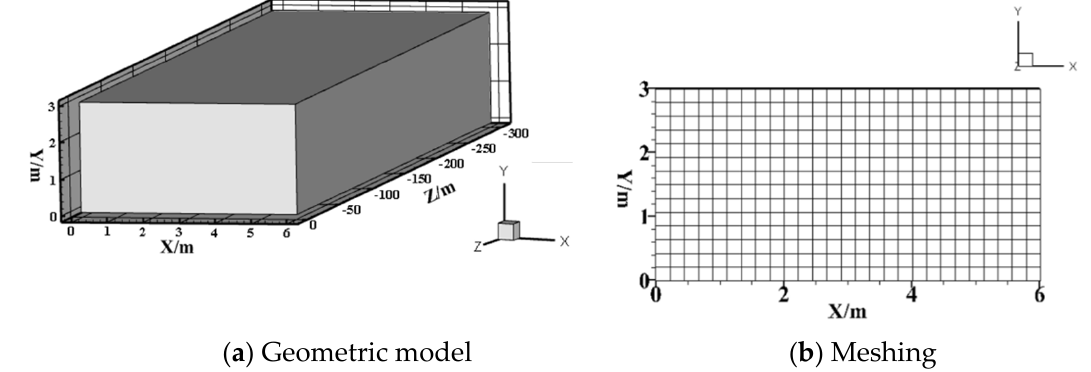
Figure 2. Geometric model of the working face.